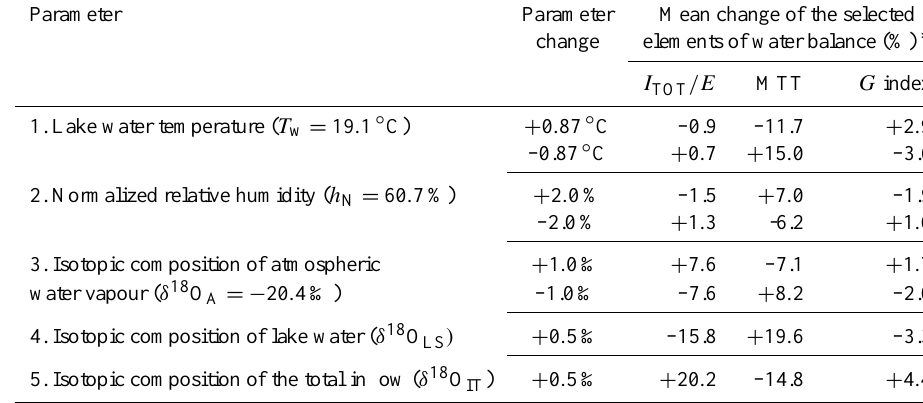
Table 3. Sensitivity of selected elements of the 18 O-based water balance of the studied lakes to changes of the parameters involved. Parameter